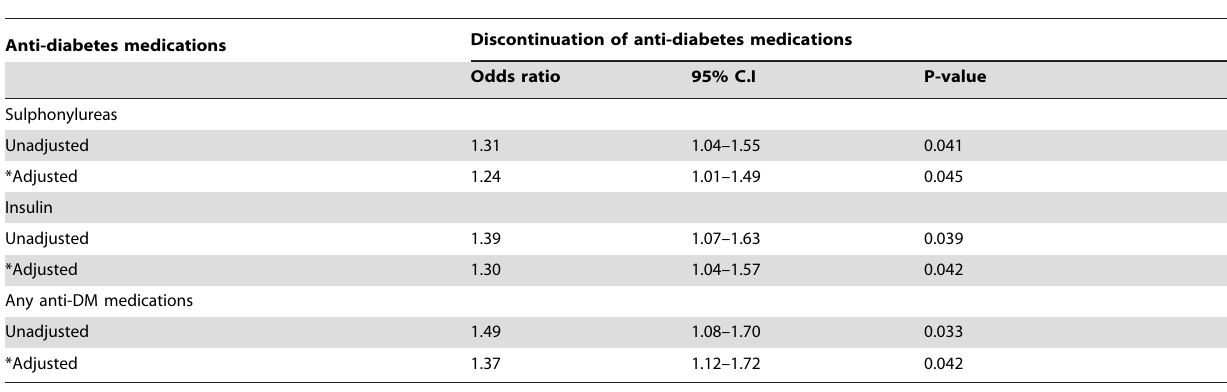
Table 6. Logistic regression analysis associating percentage weight loss (every 5%) and discontinuation of anti-diabetes medications (entire